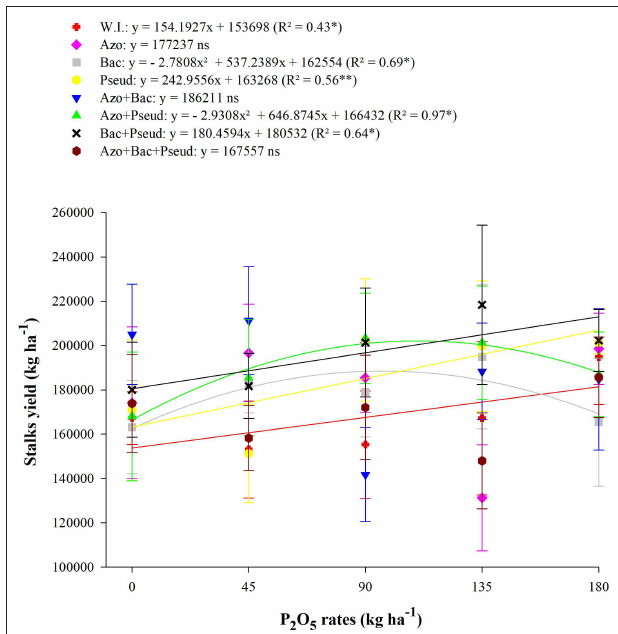
FIGURE 5 | Interactions between different bacterial inoculations and P 2 O 5 doses for stalks yield at the end of the plant-cane, RB92579 variety (Mean values ± standard deviation). **, * and ns: significant at 1 and 5% at p < 0.01, 0.01 < p < 0.05, and not significant, respectively. W.I., without inoculation; Azo, Azospirillum brasilense ; Bac, Bacillus subtilis ; Pseud, Pseudomonas fluorescens ; Azo + Bac, A. brasilense + B. subtilis ; Azo + Pseud, A. brasilense + P. fluorescens ; Bac + Pseud, B. subtilis + P. fluorescens ; Azo + Bac + Pseud, A. brasilense + B. subtilis + P. fluorescens